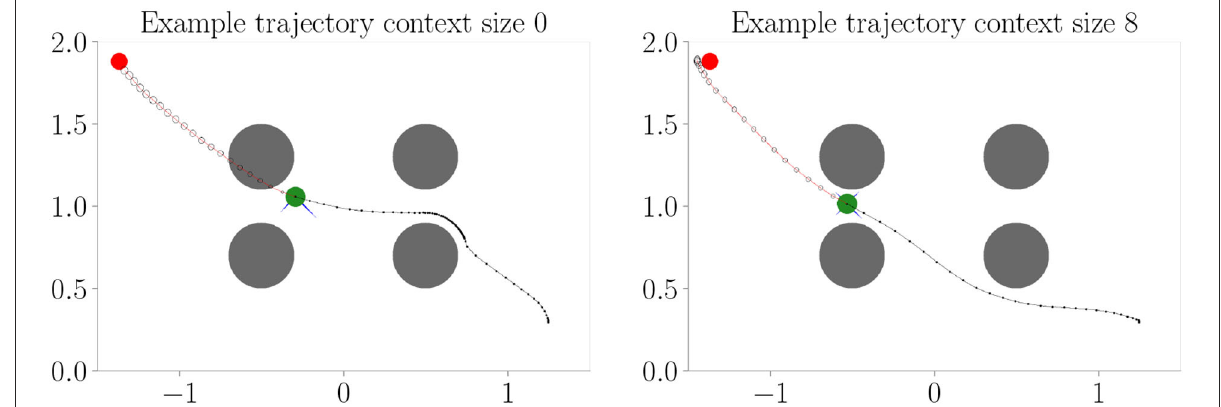
FIGURE5 Example trajectories from Experiment I–Obstacle avoidance (Section 4.3 with evolutionary-based active inference. The agent (green) flies toward the target (red) with obstacles (gray) in its way. The black line behind the agent shows its past trajectory and the line in front its planned trajectory. Circles in front of the agent show the predicted uncertainty in the sensory states. With context size 0 , the agent cannot incorporate information about the environment and, therefore, plans through and flies against the obstacles. With context size 8 , the agent can successfully plan its way around and, therefore, avoid